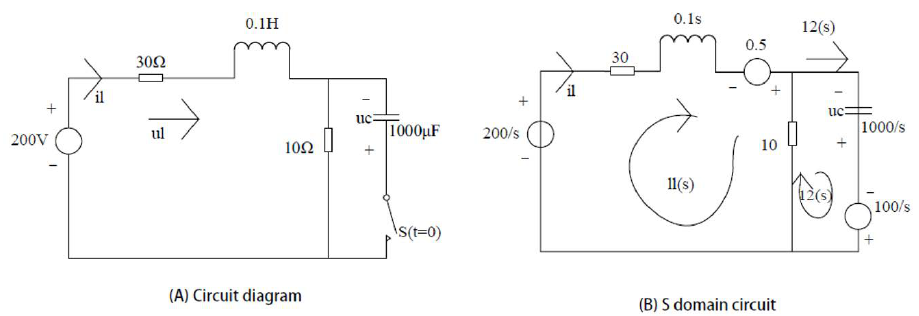
Fig. 5 Hybrid circuit with